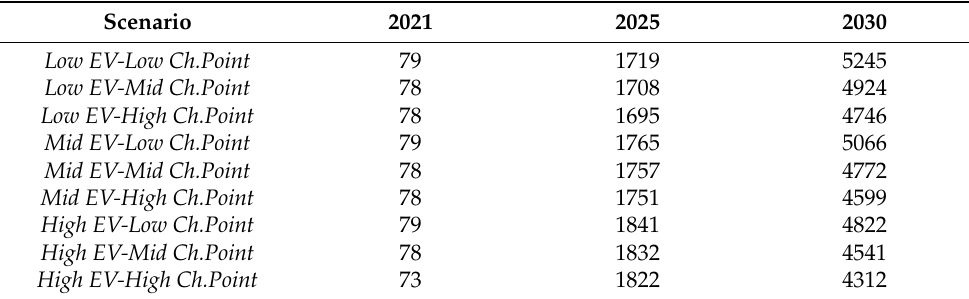
Table 8. Total available charging stations per time period.